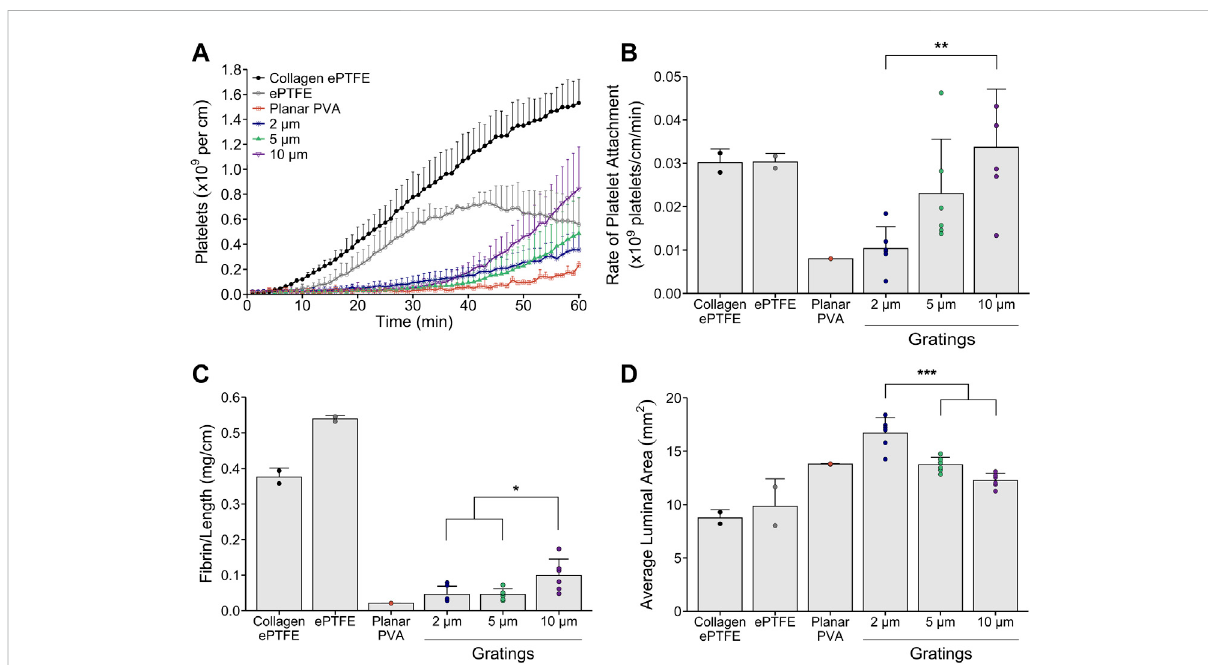
FIGURE 4 Ex vivo thrombogenicity testing of micropattern feature size under physiologic whole blood fl ow. Tubular micropatterned PVA (2, 5, or 10 µm gratings, n = 6) were tested in an ex vivo shunt model to quantify dynamic platelet attachment, rate of platelet attachment, end-point fi brin, and luminalareaofthegrafts.Micropatternedgratingswereorientedparalleltothedirectionofblood fl ow.Collagen-coatedePTFE( n =2),ePTFE( n =2), andplanarPVA(n=2)wererunasanimalcontrols. (A) Plateletaccumulation wasquanti fi edover60 minwholebloodexposureandnormalized to the axial length for all grafts. Statistical analyses were performed only on the micropatterned PVA. There were no signi fi cant differences found between the micropatterned PVA. (B) The rate of platelet attachment was quanti fi ed for the linear range of dynamic platelet accumulation. We observed a trend for increasing rate of attachment as feature size increased. A signi fi cant increase in rate was observed for the 10 µm gratings compared to the2 µmgratings. (C) Fibrin data were quanti fi edand normalized to theaxial length for all grafts. Signi fi cant differences wereobserved between 10 µm gratings compared to the 2 and 5 µm gratings. (D) The average luminal area of the grafts after exposure to whole blood fl ow were quanti fi ed using microCT image analysis. Cross-sectional area per slice of the lumen were analyzed for each graft. Signi fi cant differences were observed between 2 µm gratings compared to the 5 and 10 µm gratings. *, **, and *** indicate statistical signi fi cance ( p < 0.05, 0.01, 0.001,